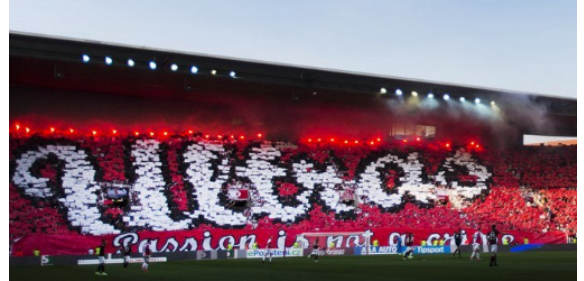
Figure 3. ULTRAS at Eden Stadium [9].